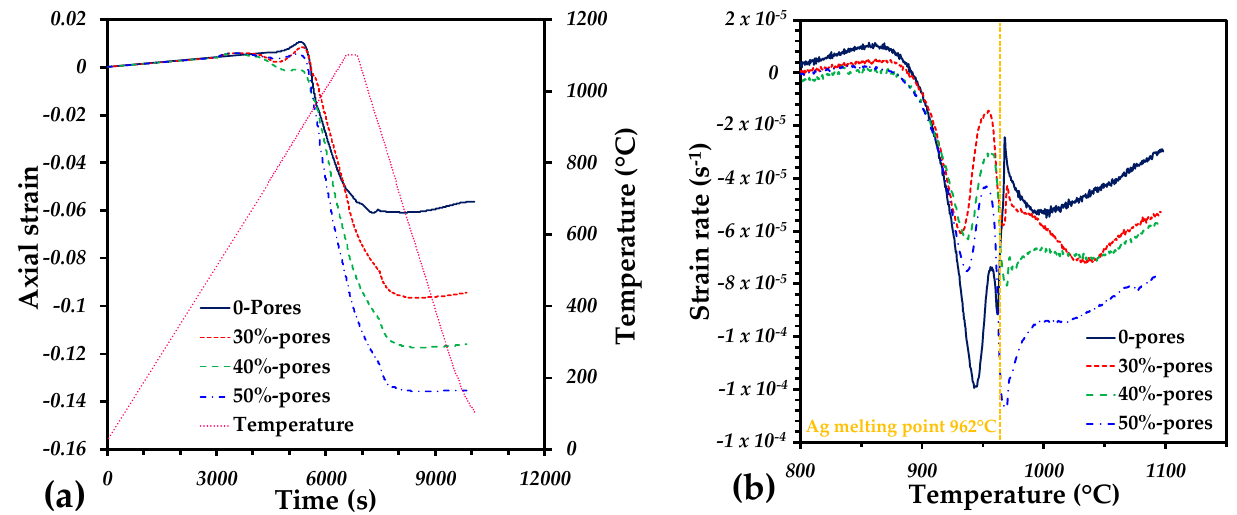
Figure 1. Dilatometry curves: ( a ) evolution of the axial strain and temperature as a function of time during sintering; ( b ) strain rate as a function of the temperature during the densification of samples.